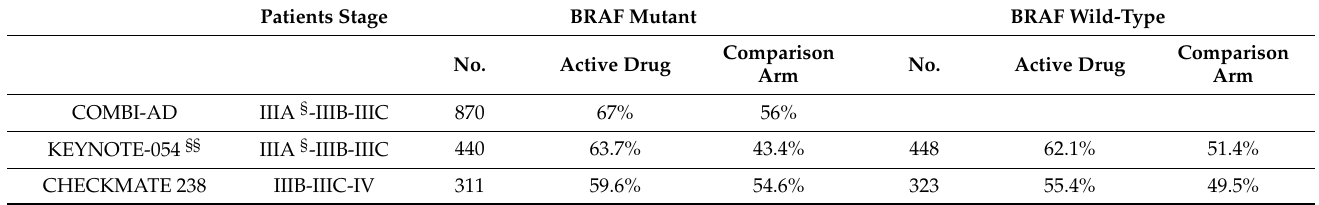
Table 1. DMFS at 4 years according to BRAF mutation